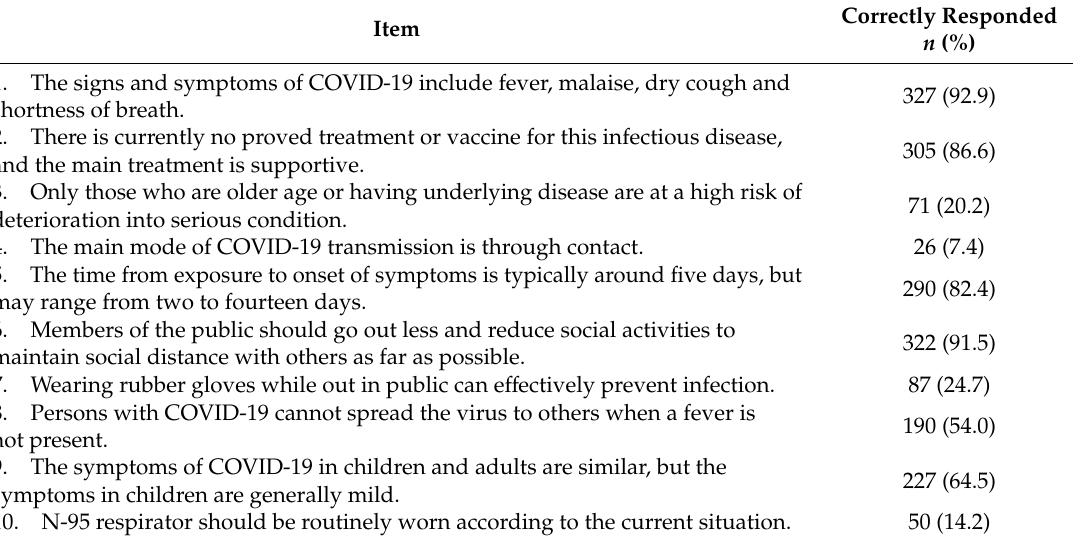
Table 2. Responses of knowledge items.